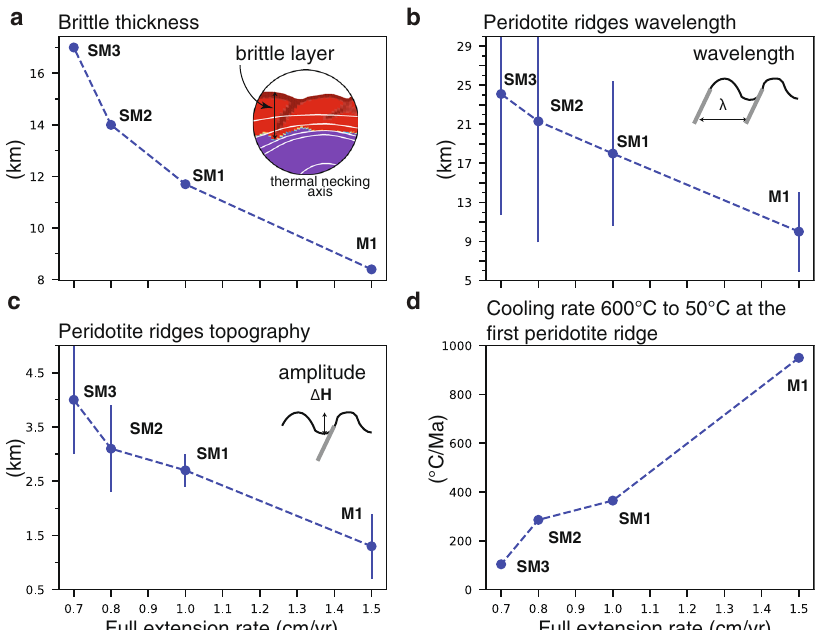
Fig. 3 Sensitivity of model behavior to varying spreading rates. a Brittle thickness on top of the active detachment fault root zone next to the thermal necking axis. Large-scale view of the plastic (brittle) domain in model M1 can be found in supplemental Fig. S8. b Average wavelength and standard deviation of the peridotite ridges. c Average amplitude and standard deviation of the exhumed peridotite ridges. d The cooling rate of the exhumed mantle at the fi rst peridotite ridge. Each point corresponds to one model run (Snapshots and model animations SM1-3 are available in the supplement material). These models only differ from model M1 by their spreading rate. We note that all these models exhibit symmetric spreading (see supplementary Fig. S9 and